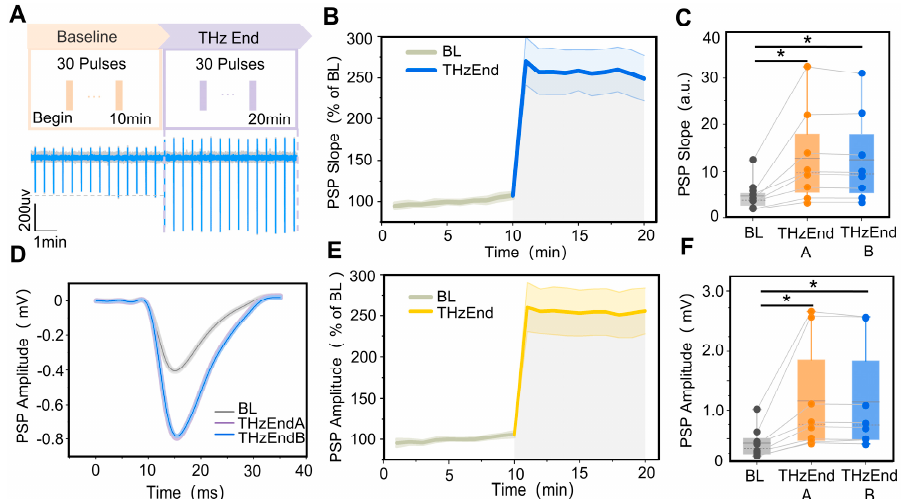
Figure 4. Terahertz radiation increases synaptic plasticity in rats’ hippocampal CA1 region. ( A ) Terahertz radiation protocol and raw signal. ( B ) The variation pattern of the CA1 PSP descent slope with terahertz radiation time, where the baseline (BL) is 10 min (grey curve) and the terahertz radiation end (THzEnd) is 10 min (blue curve). The PSP descent slope was normalized. ( C ) The slopes of the PSP at 0–5 min (THzEnd A) and 5–10 min (THzEnd B) were significantly higher than the BL. Data are mean ± SEM ( n = 8 independent experiments) *, p < 0.05 compared with BL, paired t -test. ( D ) Representative performance maps of the BL, THzEnd A and THzEnd B PSP in the CA1 region of the hippocampus. ( E ) The variation pattern of CA1 PSP amplitude with terahertz radiation time, where the (BL) is 10 min (grey curve) and THzEnd is 10 min (yellow curve); the PSP amplitude was normalized. ( F ) The amplitudes of the PSP at THzEnd A and THzEnd B were significantly higher than the BL. Data are mean ± SEM ( n = 8 independent experiments). *, p < 0.05 compared with BL, paired t -test.